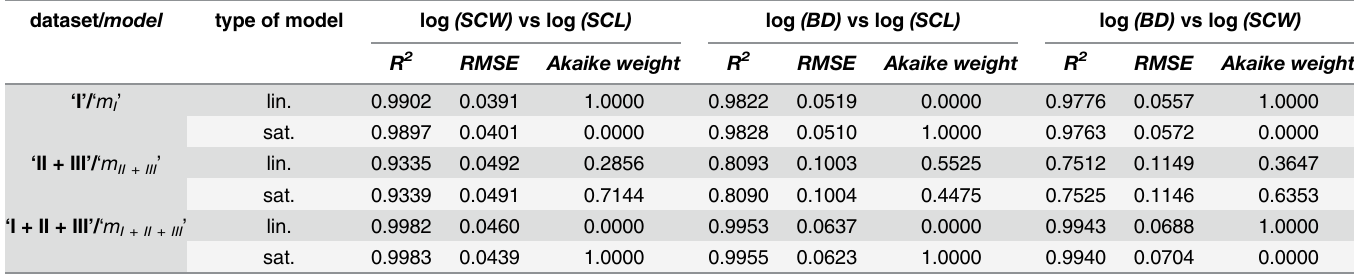
Table 7. Comparison of the linear (lin.) and saturating (sat.) type of models ‘ m I ’ , ‘ m II + III ’ , and ‘ m I + II + III ’ for the three studied relationships. Perfor- mance of models was tested on datasets ‘ I ’ , ‘ II + III ’ , and ‘ I + II + III ’ , and evaluated by goodness of fit statistics ( R 2 , Root Mean Square Error (RMSE)), and Akaike